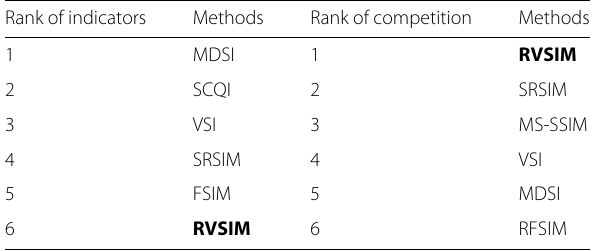
The proposed RVSIM is highlighted in